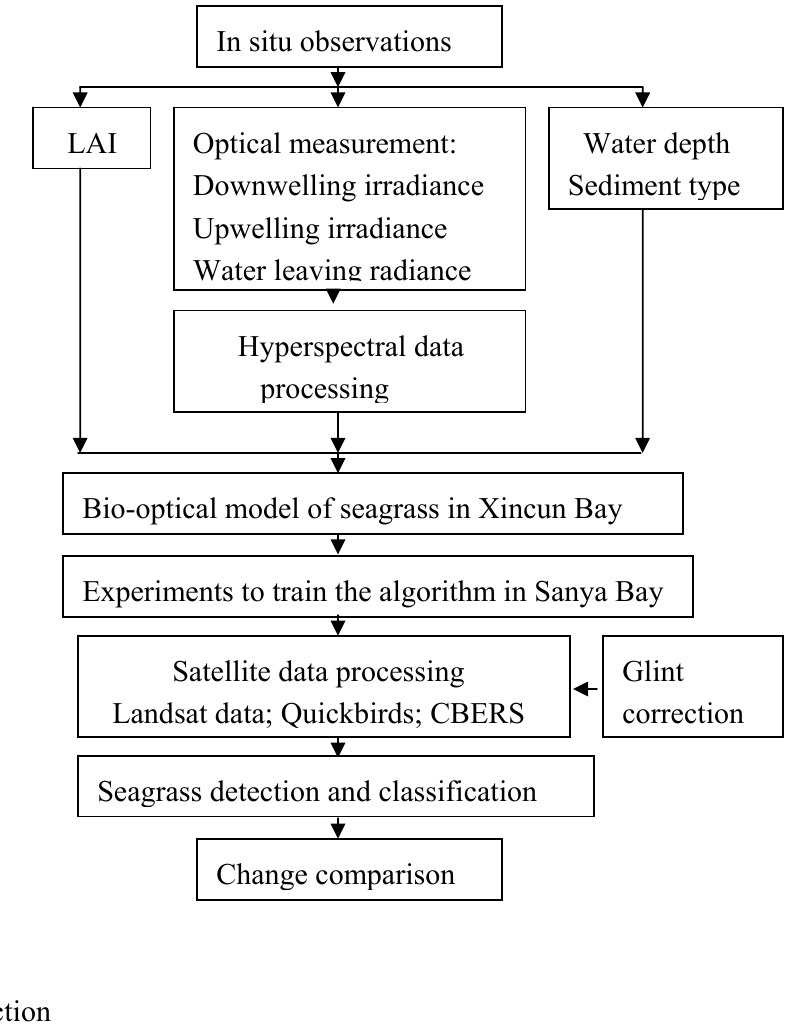
Figure 3. Flow chart of data processing for seagrass